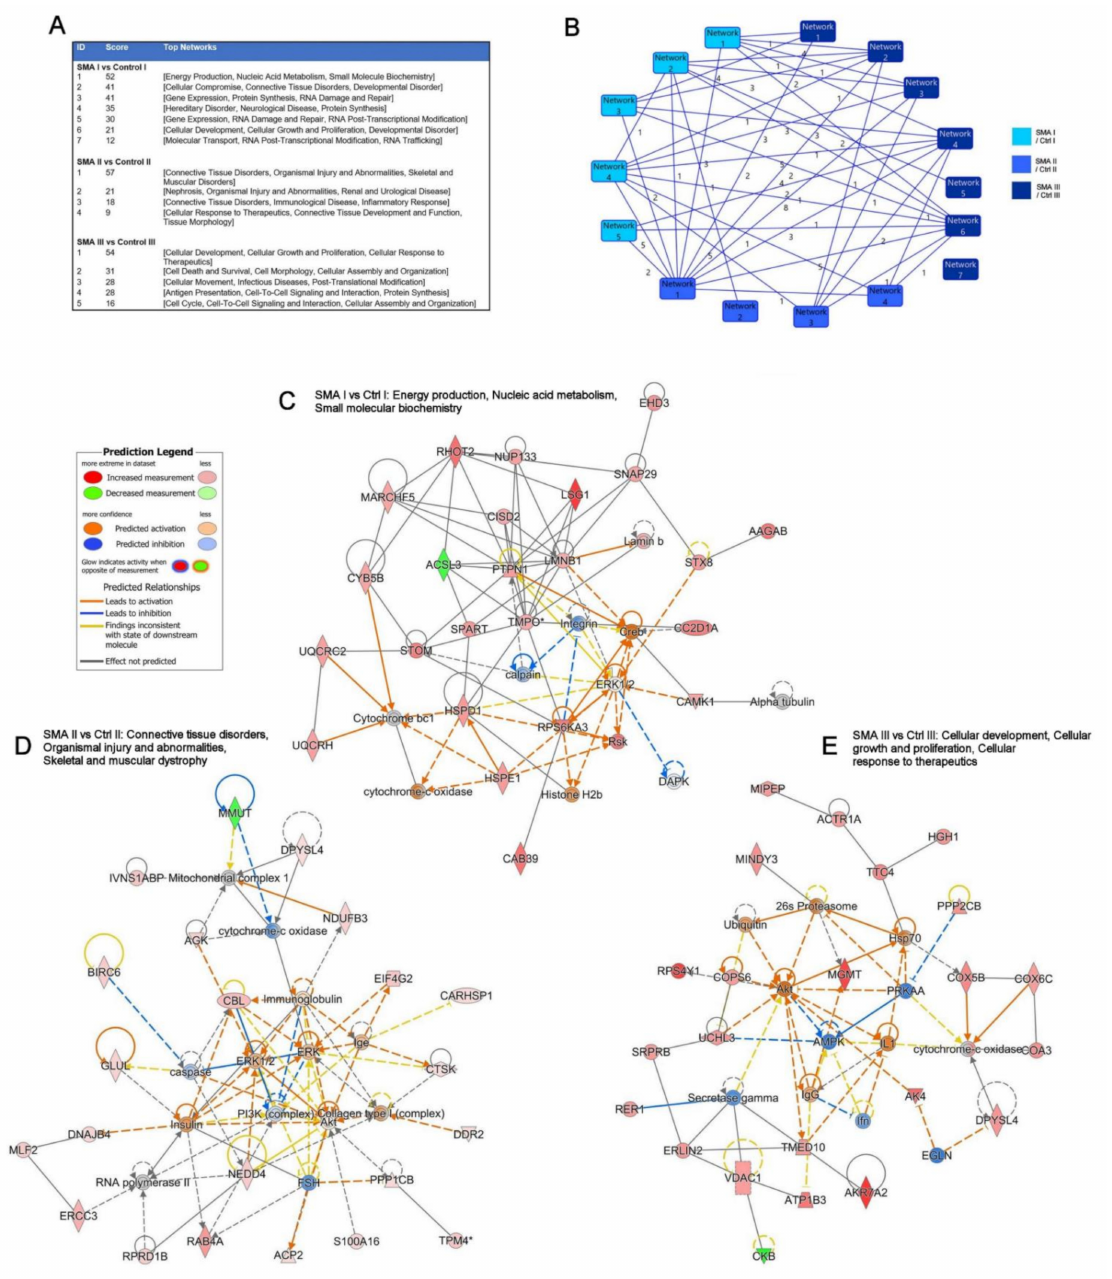
Figure 3. Network analyses of the differentially expressed proteins from each SMA type using IPA ® . ( A ) Table showing the networks associated with the differentially expressed proteins for each SMA type. The networks are scored based on the number of Network Eligible molecules they contain, with higher scores reflecting a lower probability that the molecules are present by chance. ( B ) Illustration of the interconnectivity of the networks identified for each SMA type, with numbers reflecting the overlap of specific proteins assigned to each network. Schematics of the highest scoring networks associated with the differentially expressed proteins for SMA I ( C ), SMA II ( D ) and SMA III ( E ) using the top 35 molecules for each dataset. Lines represent the biological relationship between two nodes, with direct interactions illustrated as a solid line and indirect interactions as a dotted